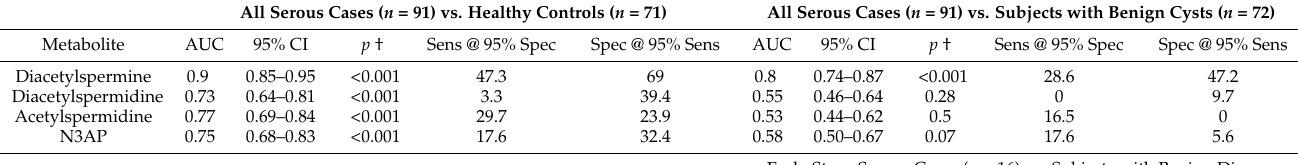
Table A5. Classification performance of plasma polyamines in distinguishing serous and non-serous cases from controls in the Test Set.